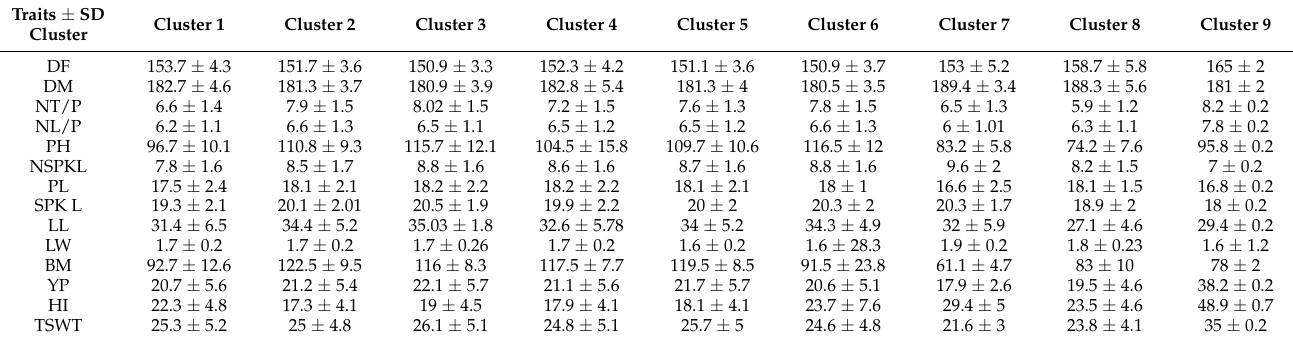
Table 4. Clustering mean based analysis of 14 quantitative traits of Oat ( Avena sativa ) genotypes for the year 2019. Traits ± SD Cluster